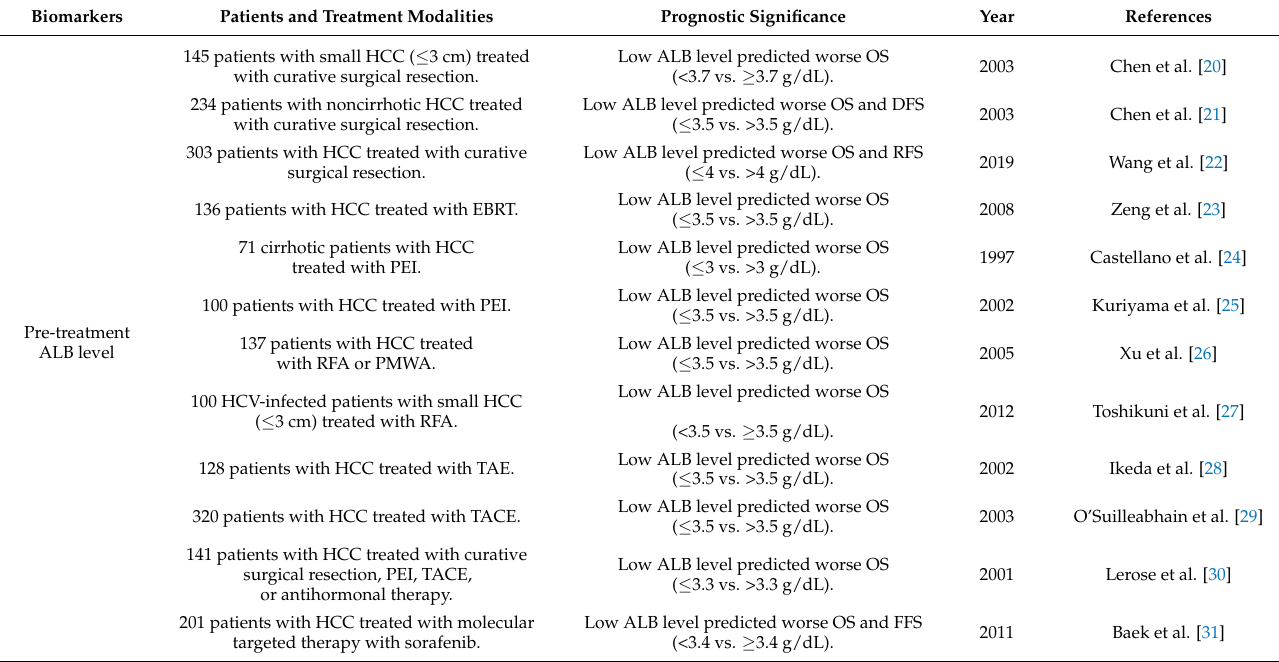
Table 1. Prognostic significance of serum ALB level in HCC patients.